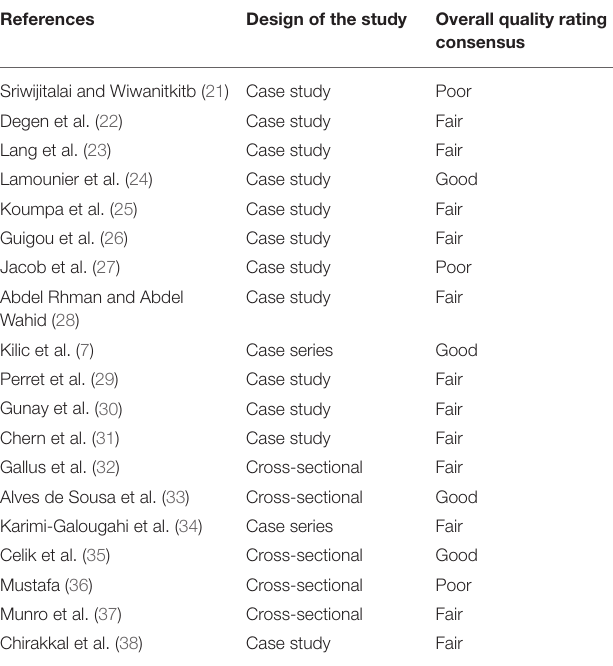
TABLE 1 | Summary of studies included in the systematic